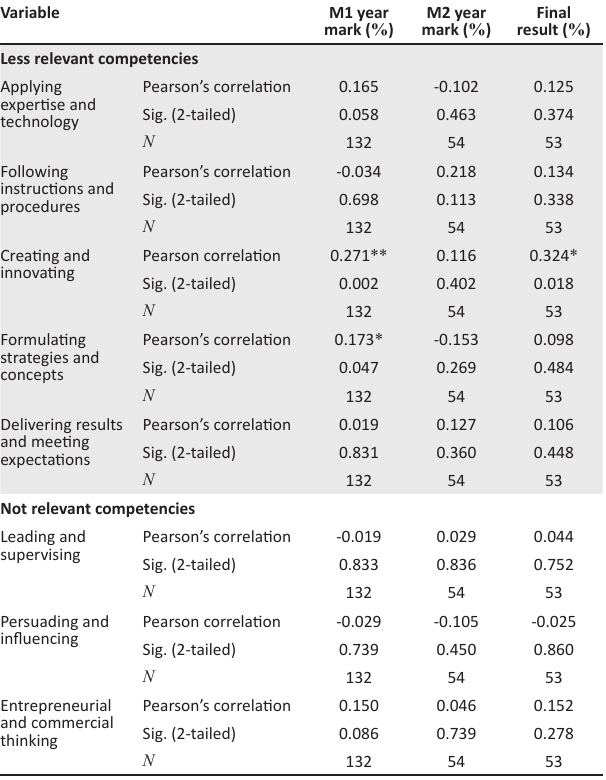
TABLE 4: Pearson’s correlation statistics: Less relevant and not relevant person job match competency scores with academic success. Variable